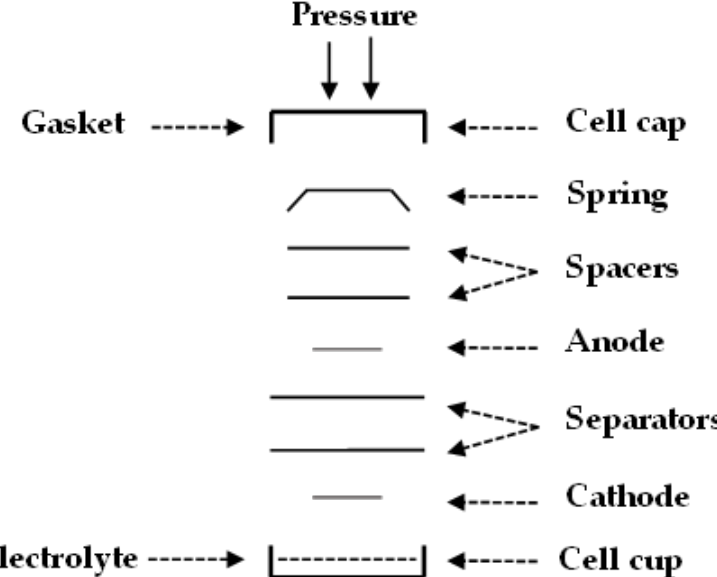
Figure 4. Schematic diagram of the structure and assembly of a coin cell.